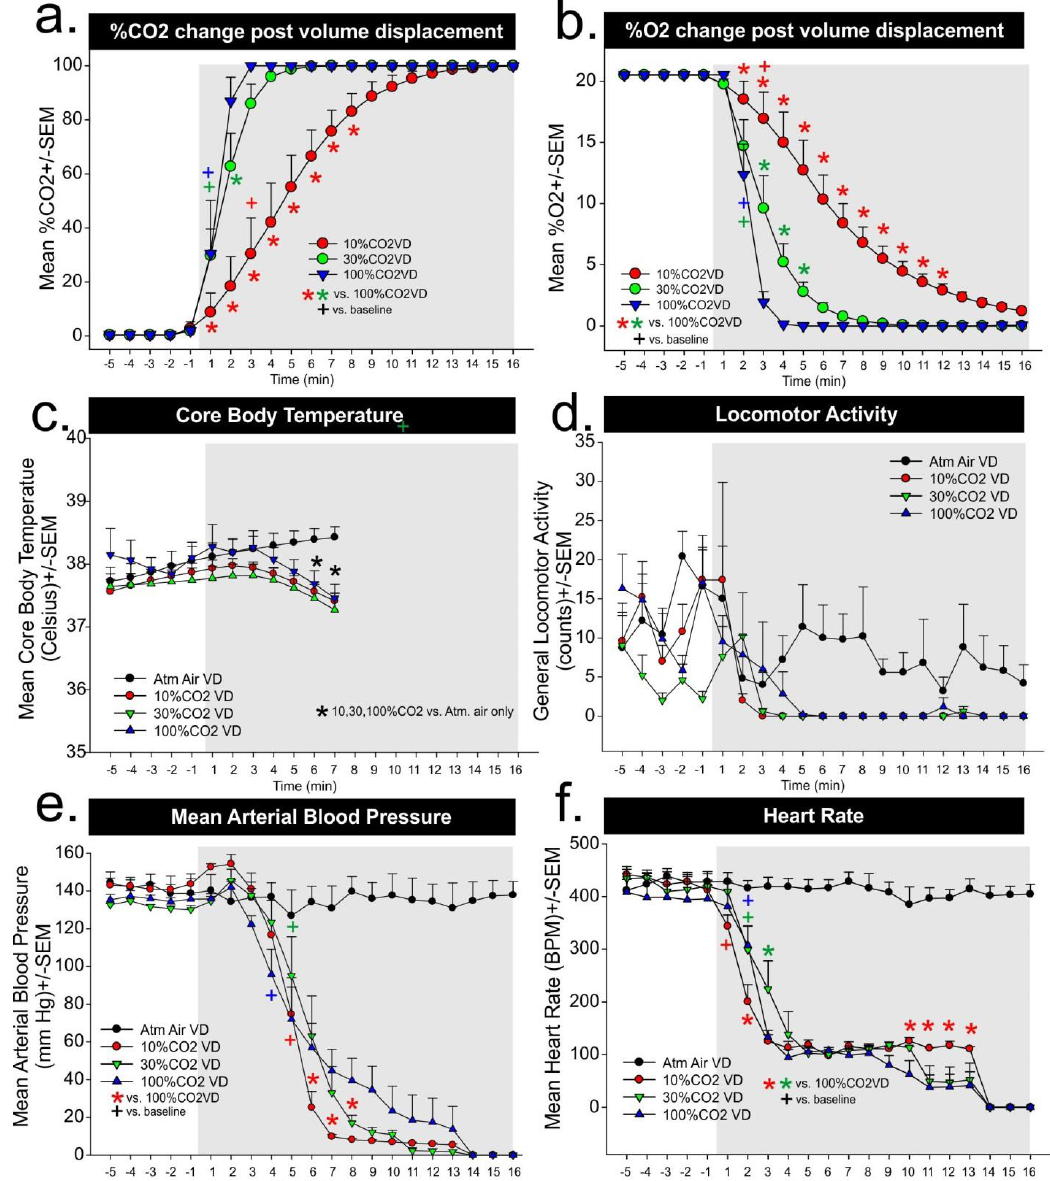
Figure 2. Line graphs in ( a – f ) respectively represent ambient concentrations of CO 2 and O 2 ; core body temperature (Celsius); general locomotor activity (counts/min); mean arterial blood pressure (mmHg); and heart rate (beats per minute) when placed in volume displacement cage for 5 min prior to either infusions of atmospheric air (Atm air), or 10%, 30%, or 100% CO 2 volume displacement per minute procedures (gray shaded region). * represents between-subject significance p < 0.05 with a Fisher’s LSD post hoc test protected by a significant one-way ANOVA with gas treatment as the main factor and time as a repeated measure.